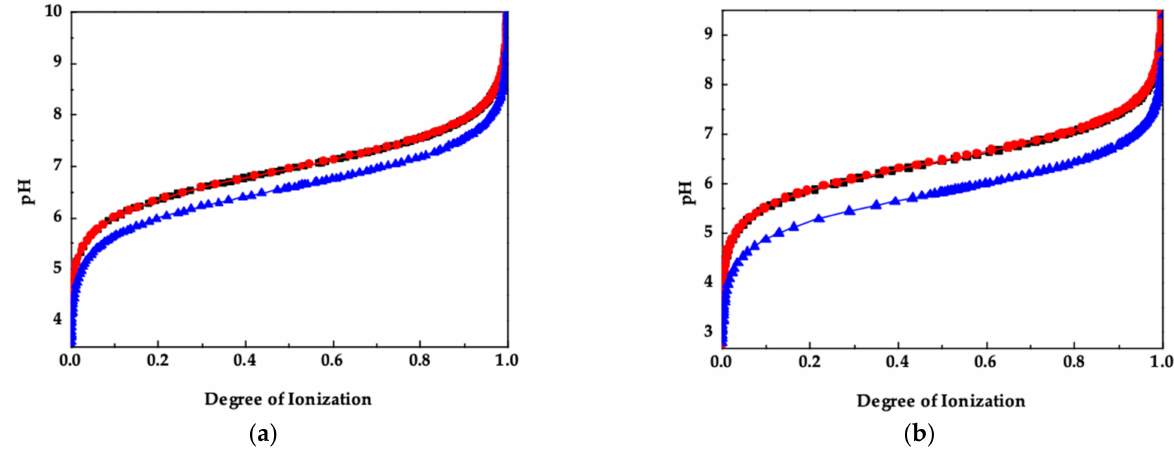
Polymers 2021 , 13 , x FOR PEER REVIEW 12 of 19 Figure 4. Potentiometric titration data plotted as the pH vs. the degree of ionization (0 < α <1) of the carboxylic acid side groups for ( a ) PE-Prop50 ( (cid:4) ), PE-Prop80 ( • ) and PE-Prop100 ( (cid:78) ) and ( b ) PE-Glyc50 ( (cid:4) ), PE-Glyc80 ( • ) and PE-Glyc100 ( (cid:78) ).